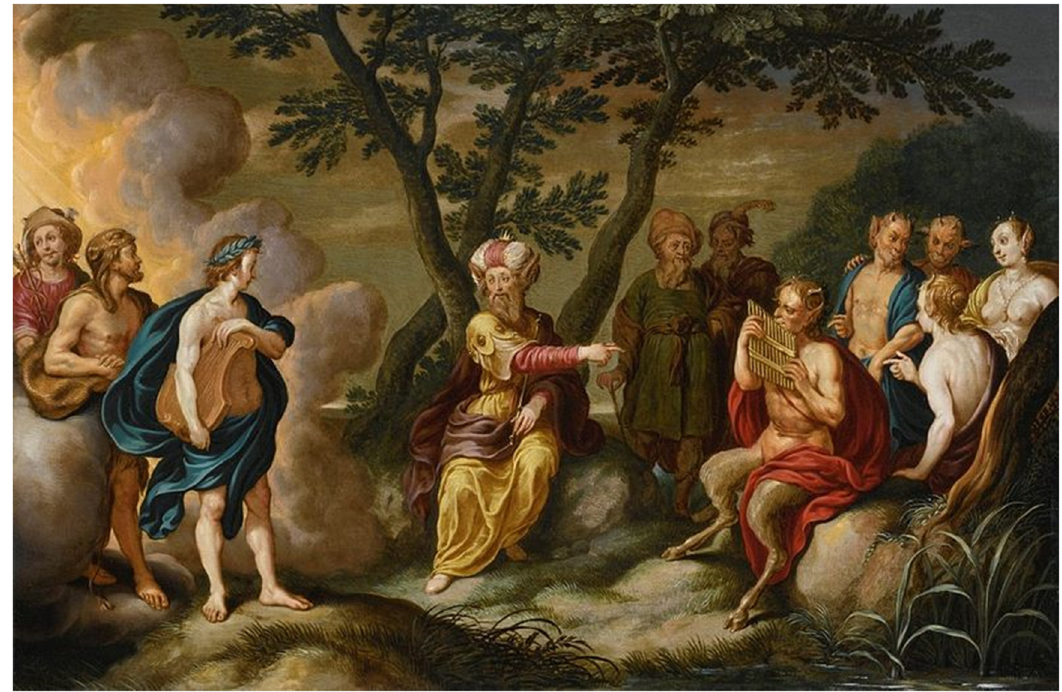
Figure 19: Simon Floquet, Apollo and King Midas , 1634. Oil on copper. Private possession. Public